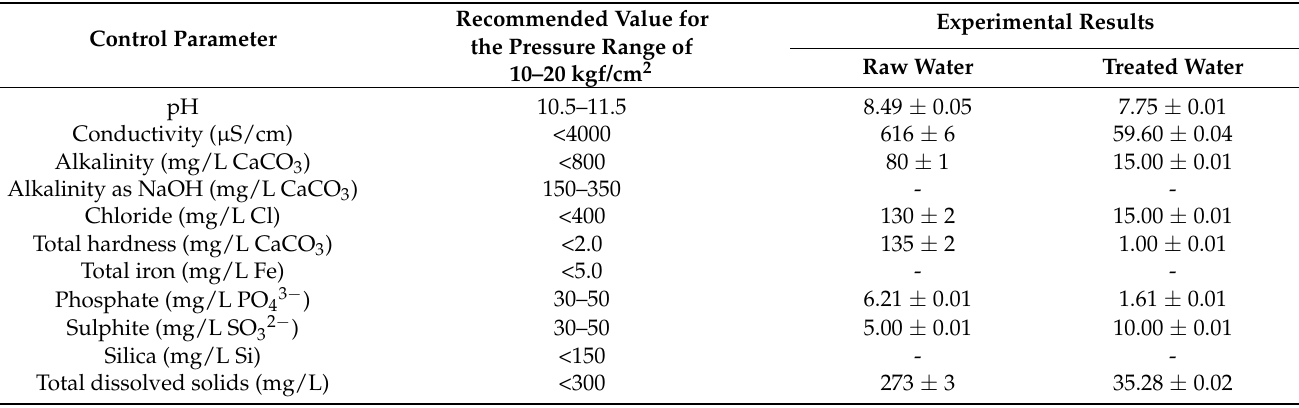
Table 5. Values of physicochemical parameters for water and treated water before and after a single pass through the irradiation chamber of the bench ‐ scale prototype.